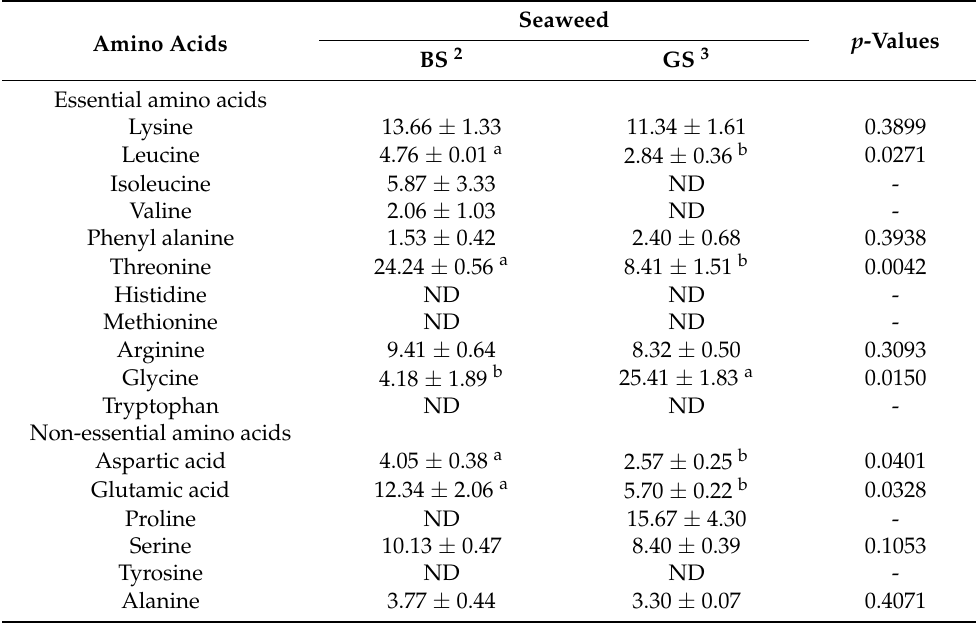
Table 4. Amino acids content of seaweed (ng 1 /mg of dry basis